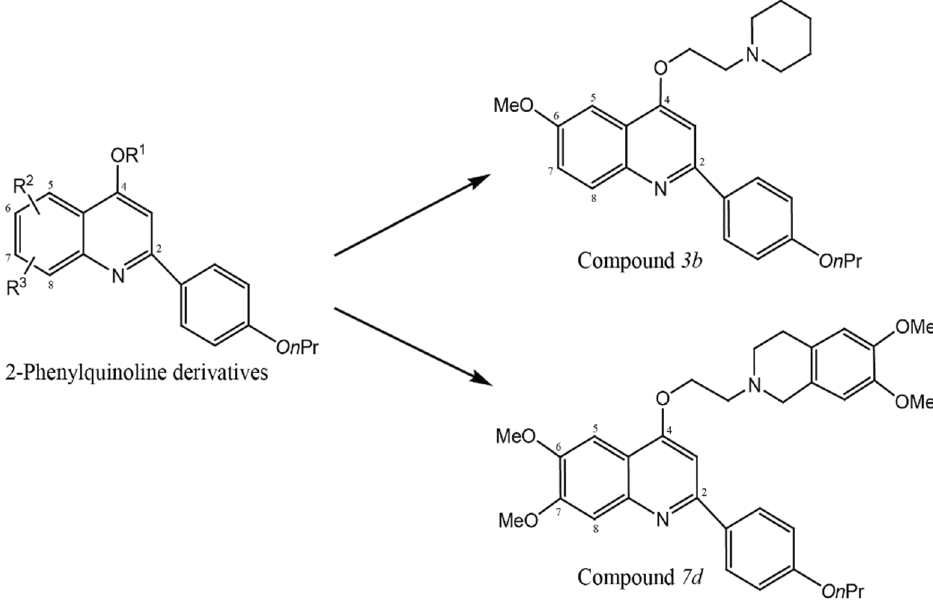
Figure 6. Structure modifications of 2-Phenylquinolone derivatives were required to obtain two series, two novel methoxy-2-Phenylquinolone derivatives ( 3b and 7d ). The picture was generated by used ChemDraw pro 8 . 0 .